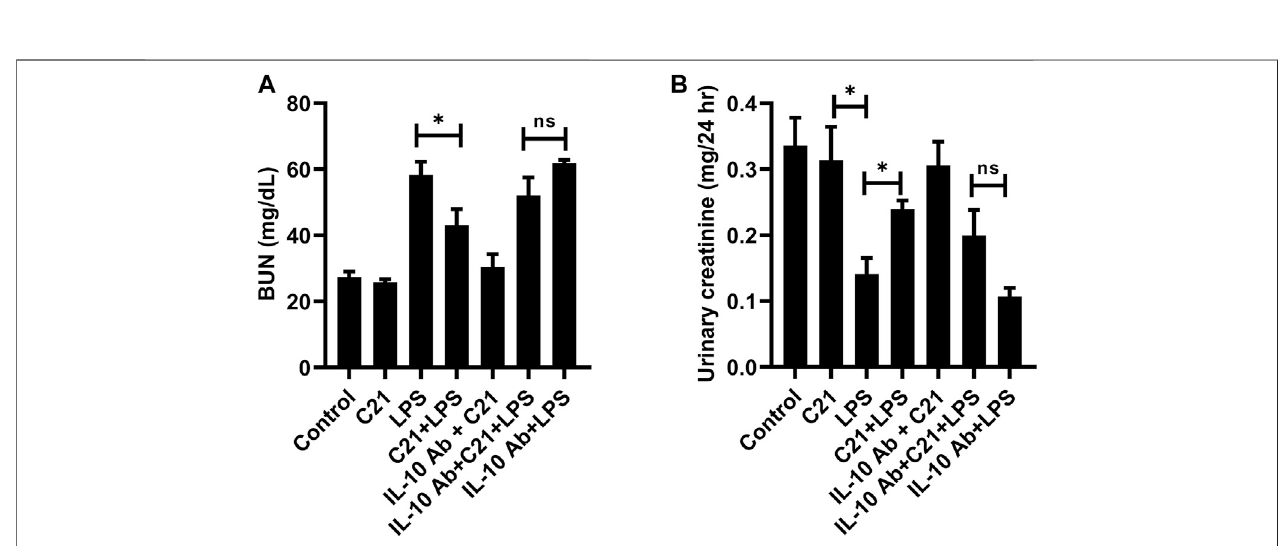
FIGURE 6 | Measurement of functional indices of the kidney (A) BUN and (B) urinary creatinine following 24 h LPS challenge in C57BL6/NHsd mice treated with C21,LPS,orbothwithandwithoutneutralizingIL-10antibody.DataarerepresentedasMean ± S.E.M.,analyzed byone-wayANOVAwithFisher ’ sLSDtestformultiple comparisons and are considered signi fi cant at * p <